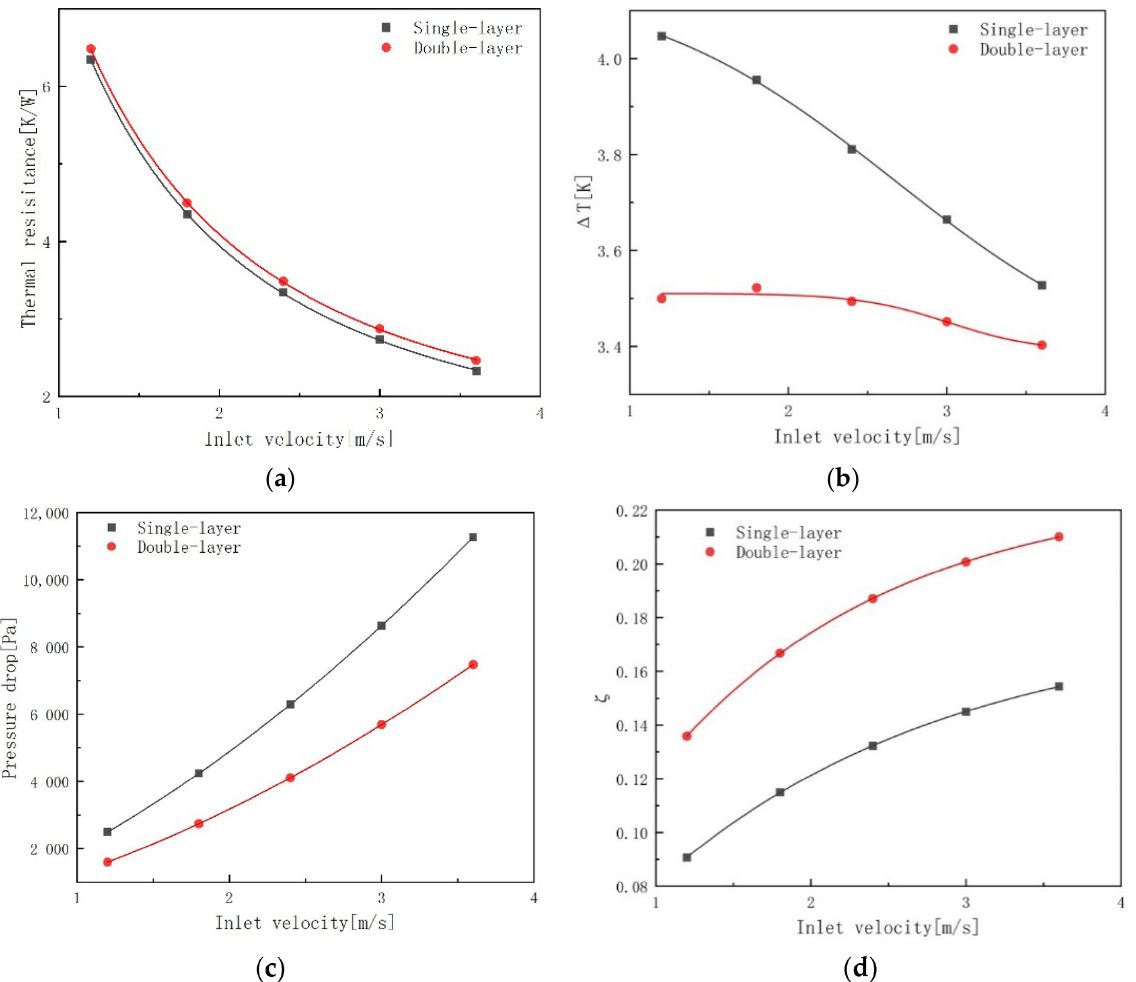
Figure 8. Comparison of flow and heat transfer performance of the double-layer and single-layer pin–fin MMC: ( a ) thermal resistance; ( b ) maximum temperature difference; ( c ) pressure drops; and ( d ) comprehensive